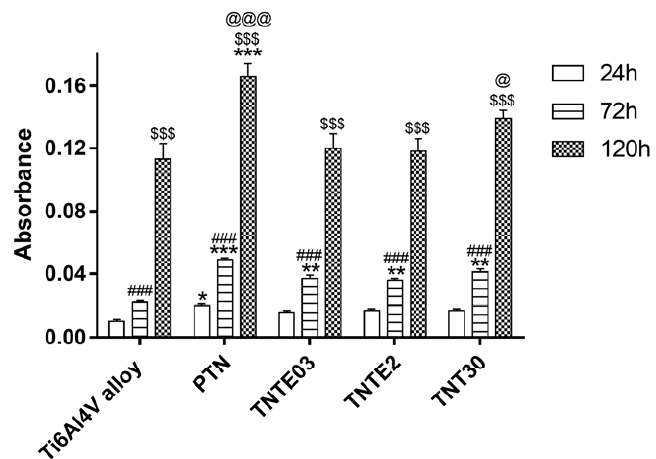
Figure 7. Effect of the tested nanocoatings on the murine fibroblasts L929 adhesion (after 24 h) and proliferation (after 72 h and 120 h) detected by MTT assay. The absorbance values are expressed as means ± S.E.M. of three independent experiments. Asterisks indicate significant differences between the fibroblasts incubated with Ti6Al4V alloy references sample compared to the porous titania nanocoating (PTN), titania nanoteeth (TNTE03 and TNTE2) and the reference sample of titania nanotube coating (TNT30) at appropriated incubation time (* p < 0.05, ** p < 0.01, *** p < 0.001). Hash marks denote significant differences between the cells incubated with the same tested nanomaterial for 24 h in comparison to 72 h ( ### p < 0.001). $ marks indicate significant differences between the fibroblasts incubated with the specified nanomaterial for 72 h compared to 120 h incubation time ( $$$ p < 0.001). @ marks denote significant differences between titania nanoteeth and TNT30 or PTN samples ( @ p < 0.05, @@@ p <